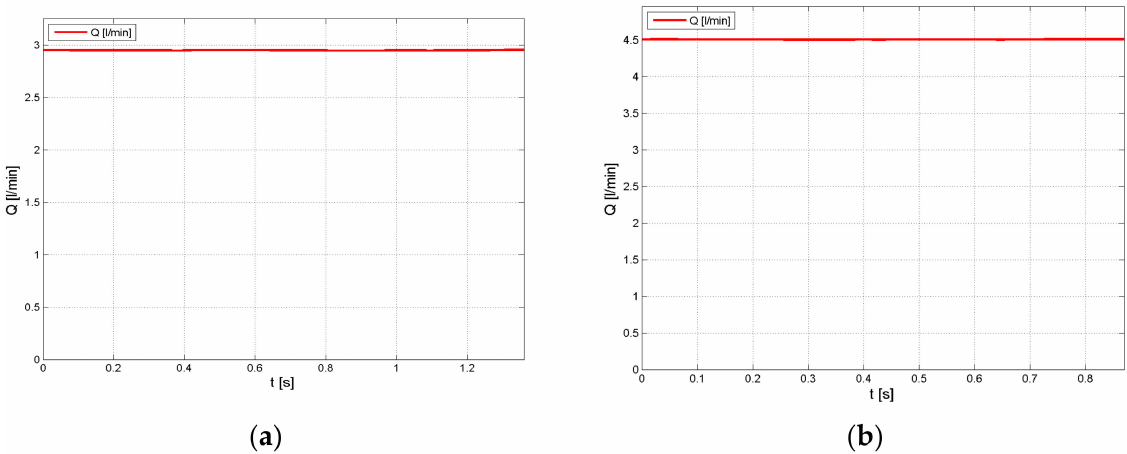
Figure 13. Waveforms of the pump flow rate (Q) at 60 bar pressure for the speed of: ( a ) 1000 rpm; ( b ) 1500